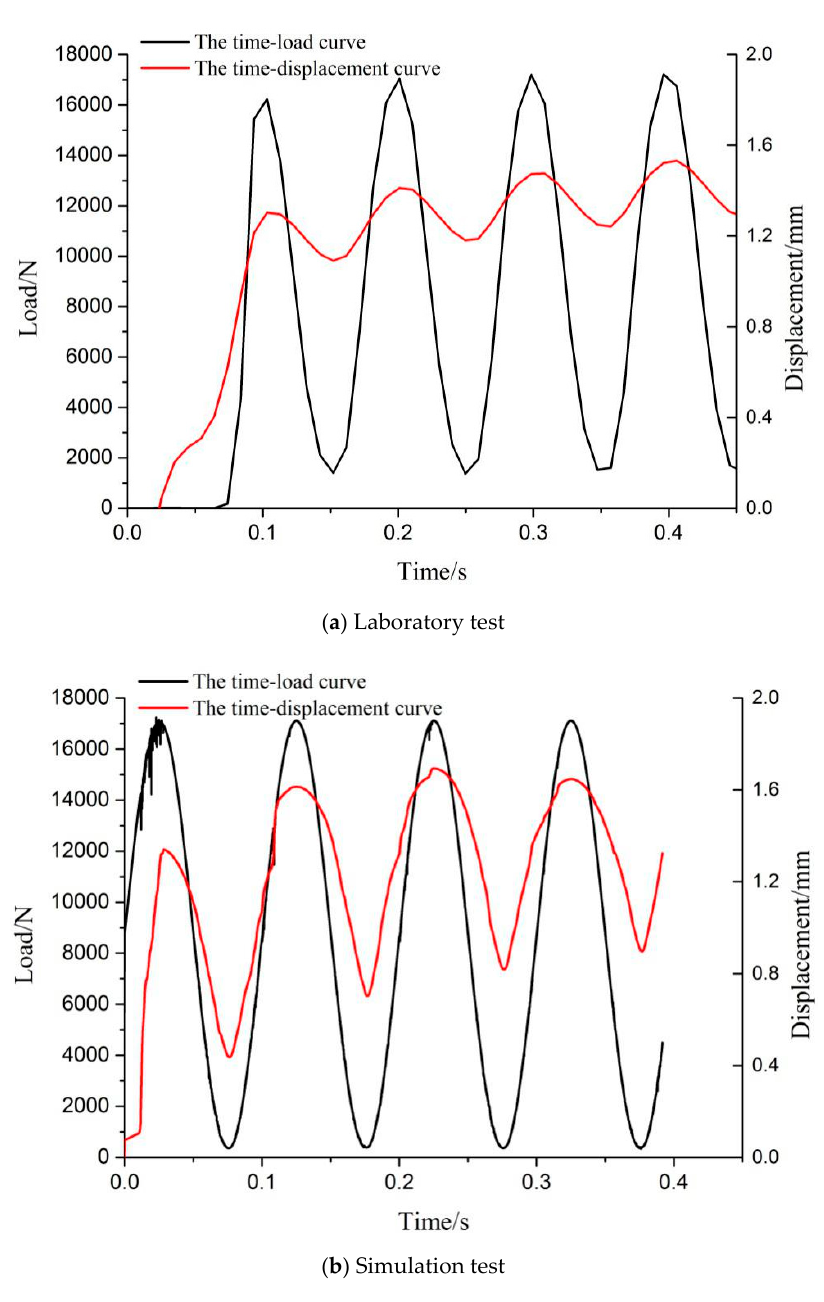
Figure 13. Time-load curves and time-displacement curves.